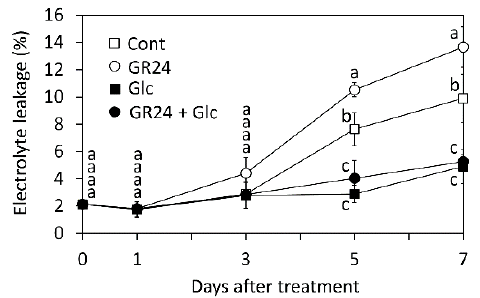
Figure 5. Effects of GR24 and glucose (Glc) on electrolyte leakage from rice leaf segments. Leaf segments were treated with 1 µM GR24 and 1% Glc at 25 °C in dark. The control (Cont) was treated without GR24 and Glc. Values and bars show means ± SD ( n = 3). Letters show a significant difference ( p < 0.05) as determined by Tukey’s HSD test at the same time point.